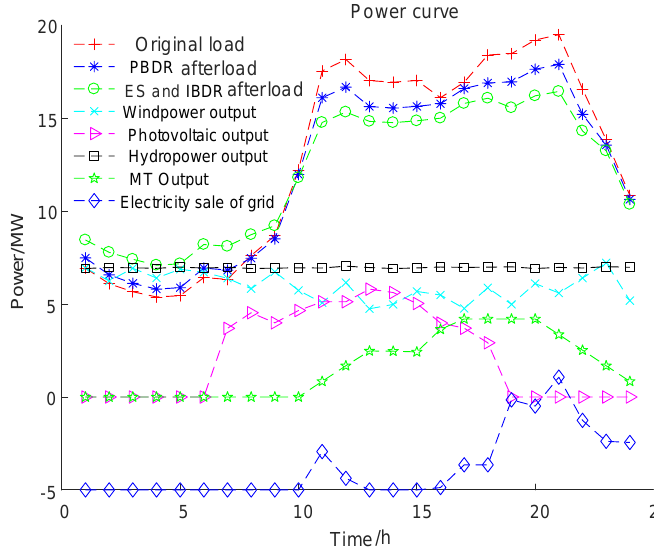
Figure 4. Typical daily simulation results.